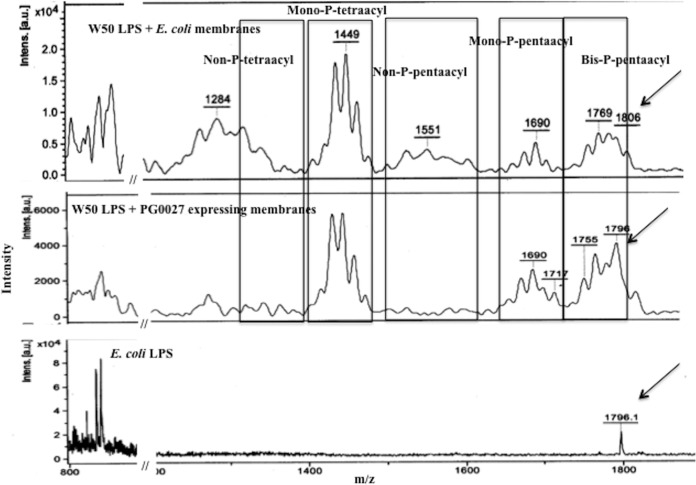
Lipid A modification assays of PG0027-expressing membranes (in E. coli) with P. gingivalis W50 LPS as the substrate. P. gingivalis W50 LPS was incubated with E. coli membranes containing EXT20 (top panel) or PG0027-expressing membranes (MFH15) (middle panel). Lipid A was isolated from the reaction mixture as described in Materials and Methods and analyzed by MALDI-TOF MS in linear negative-ion mode. The bottom panel shows lipid A isolated from E. coli DH5α cells. The arrows show E. coli lipid A. Intens. [a.u.], intensity in arbitrary units.